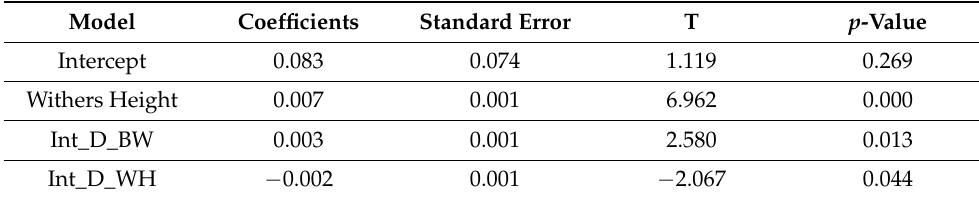
Table 7. Coefficients of stepwise backward regression for the dependent variable thoracic